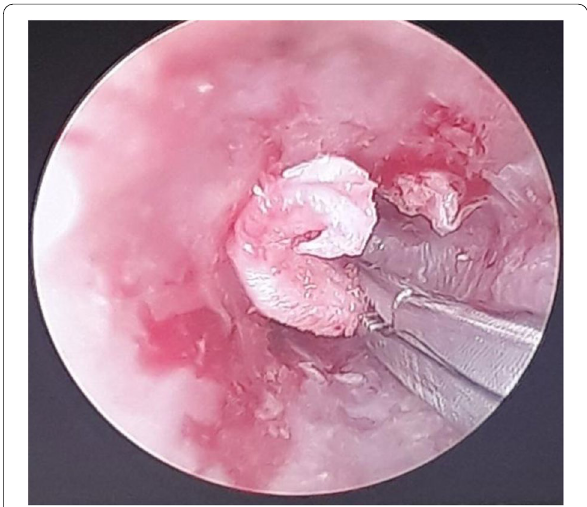
Fig. 2 The cartilage graft being placed to through the EAC